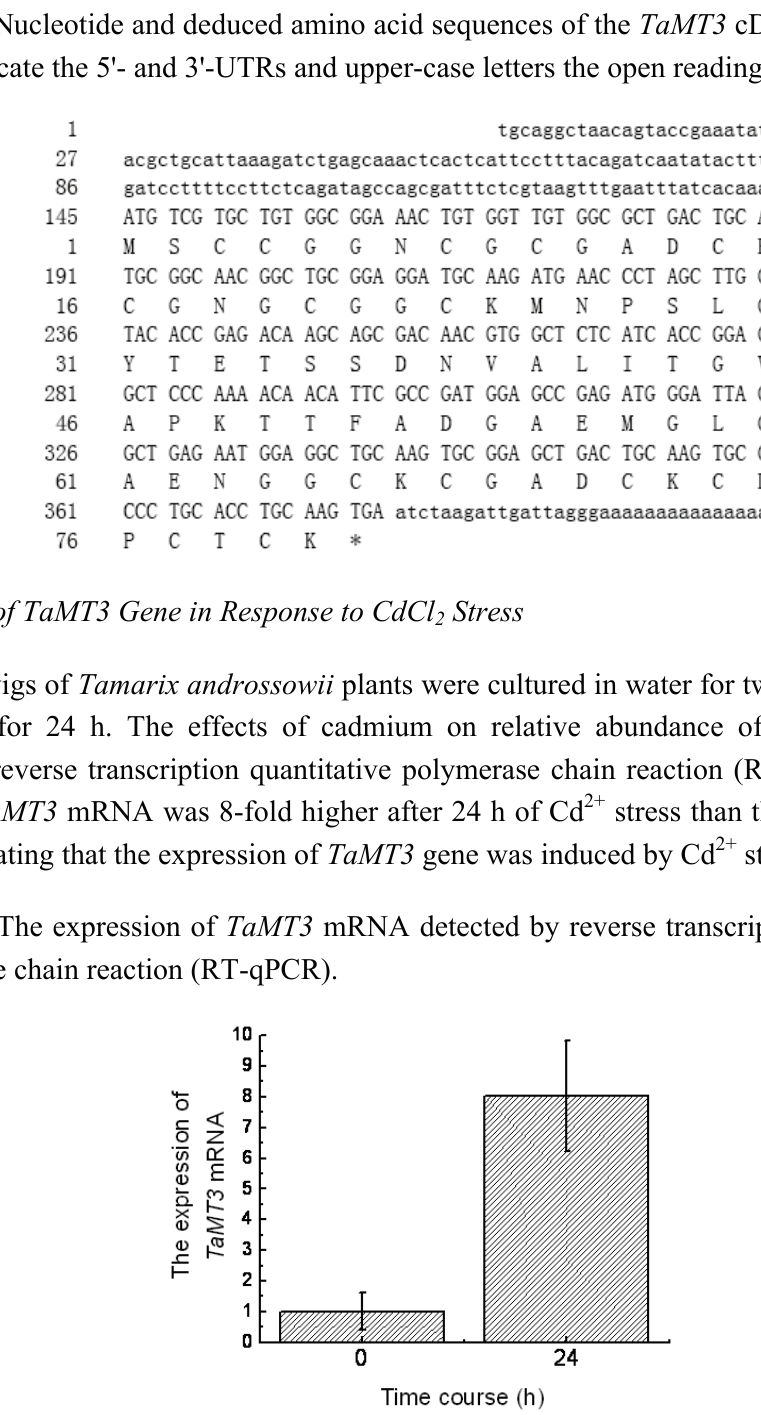
Figure 1. Nucleotide and deduced amino acid sequences of the TaMT3 cDNA. Lower-case